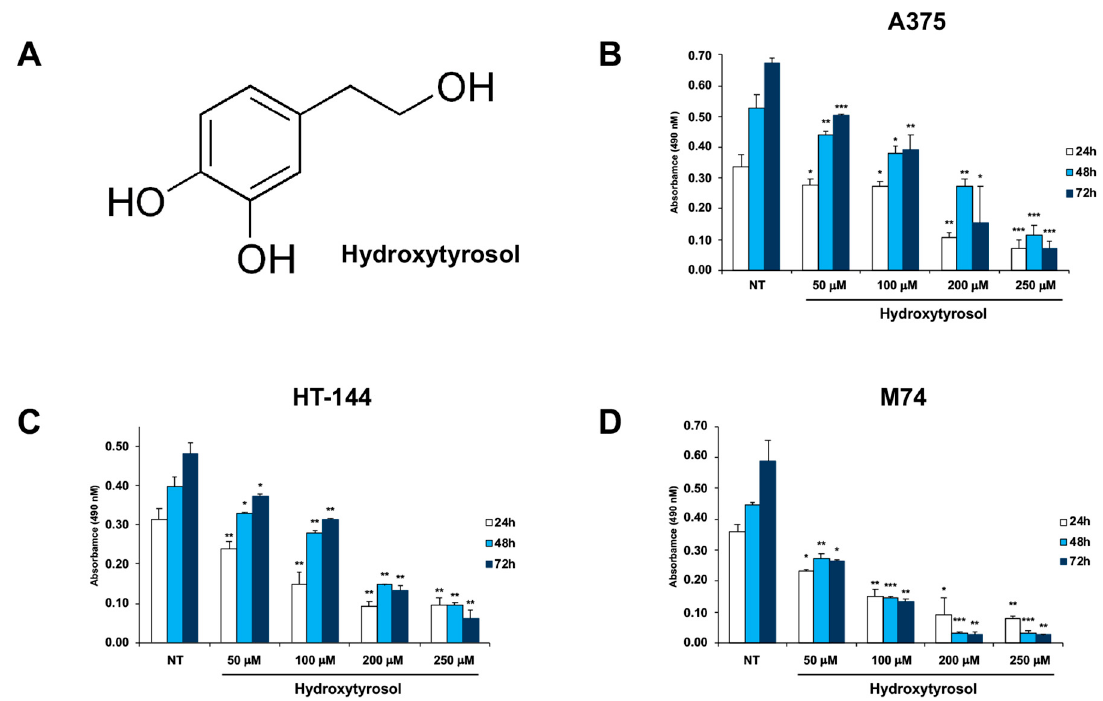
Figure 1. MTS assay of hydroxytyrosol treated melanoma cells. ( A ) Structure of hydroxytyrosol. A375 ( B ), HT-144 ( C ), and M74 ( D ) melanoma cells were treated with 50 μ M, 100 μ M, 200 μ M, and 250 μ M